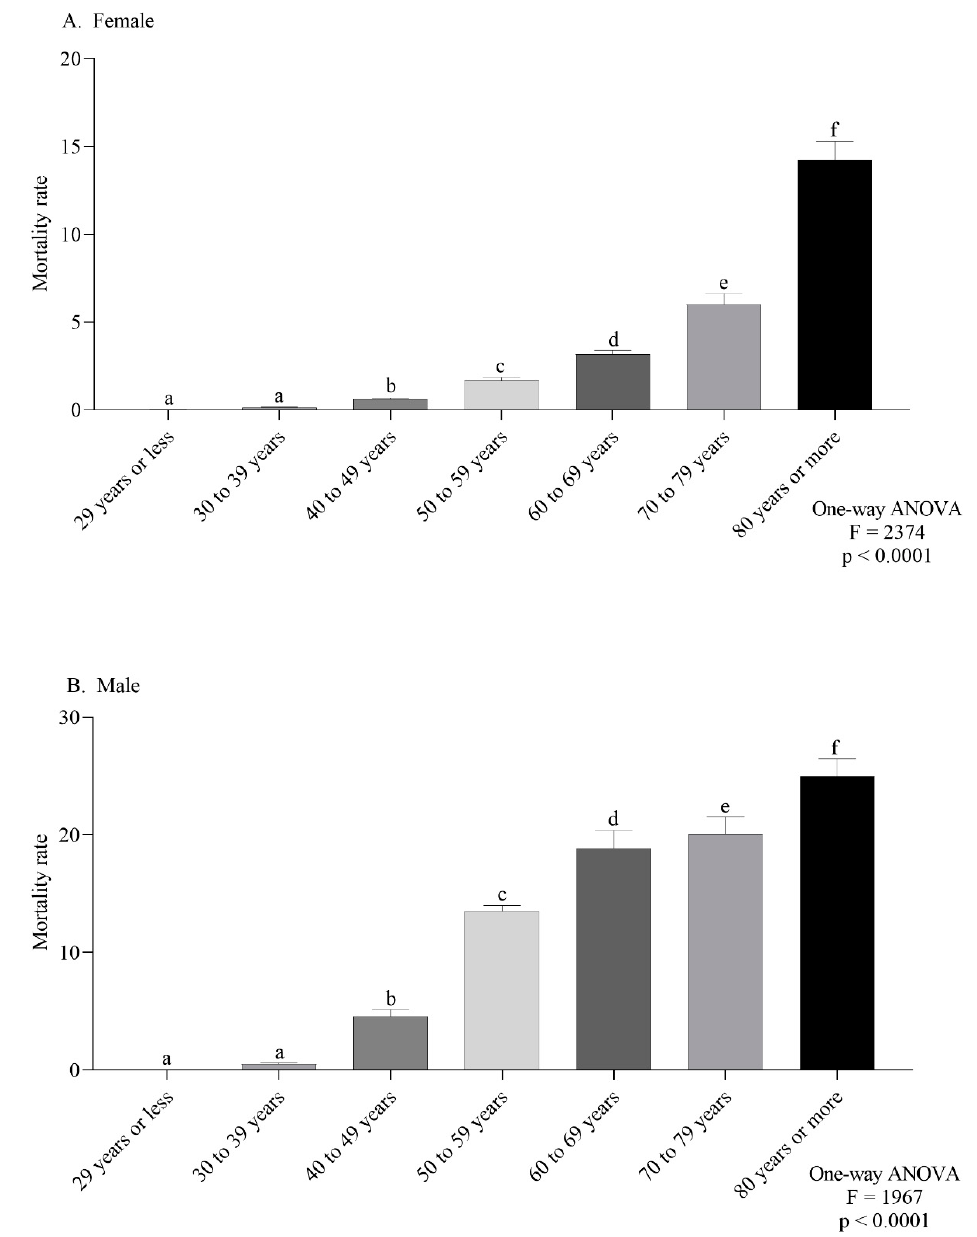
Figure 5. Mortality rate for every 100,000 inhabitants per sex (female ( A ) or male ( B )) according to age group ( A , B ). Lowercase letters indicate significant differences between age groups ( p < 0.05, Dunn’s test).